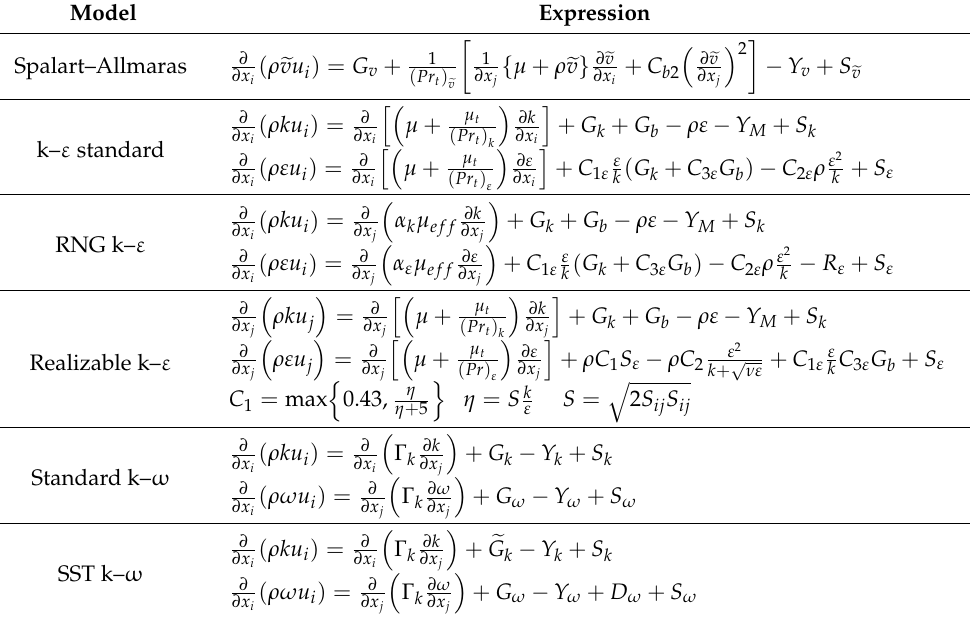
Table 2. Summarization of the turbulence